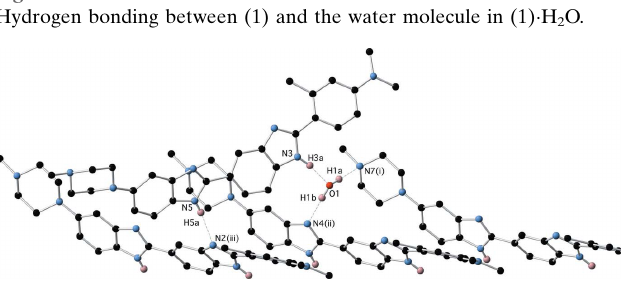
Figure 8 Hydrogen bonding between (1) and the water molecule in (1) (cid:2) H 2 O.